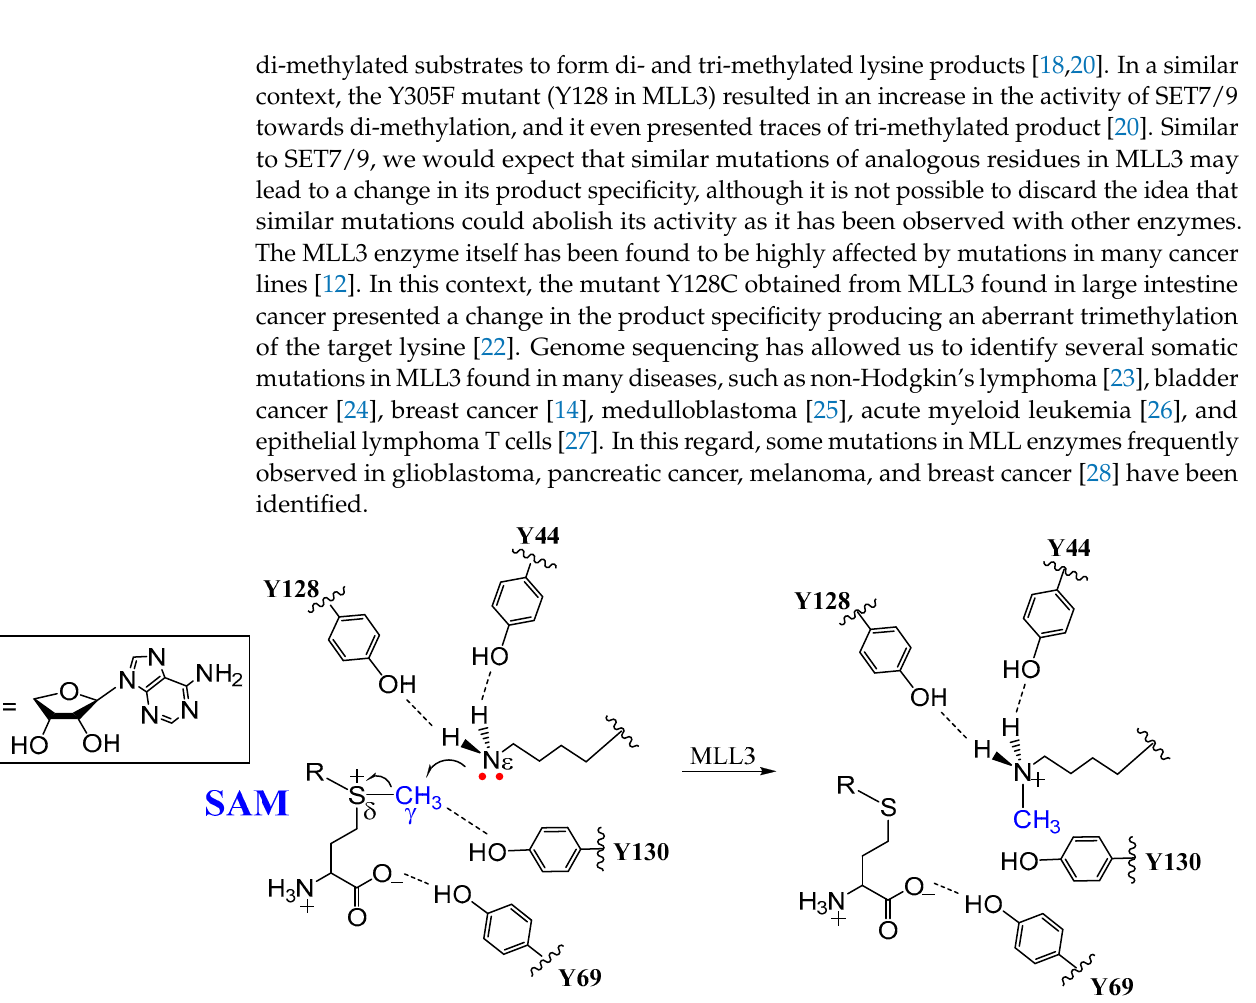
Scheme 1. Chemical representation of the catalytic machinery of MLL3 and its involvement in the reaction mechanism for the methyl-transfer